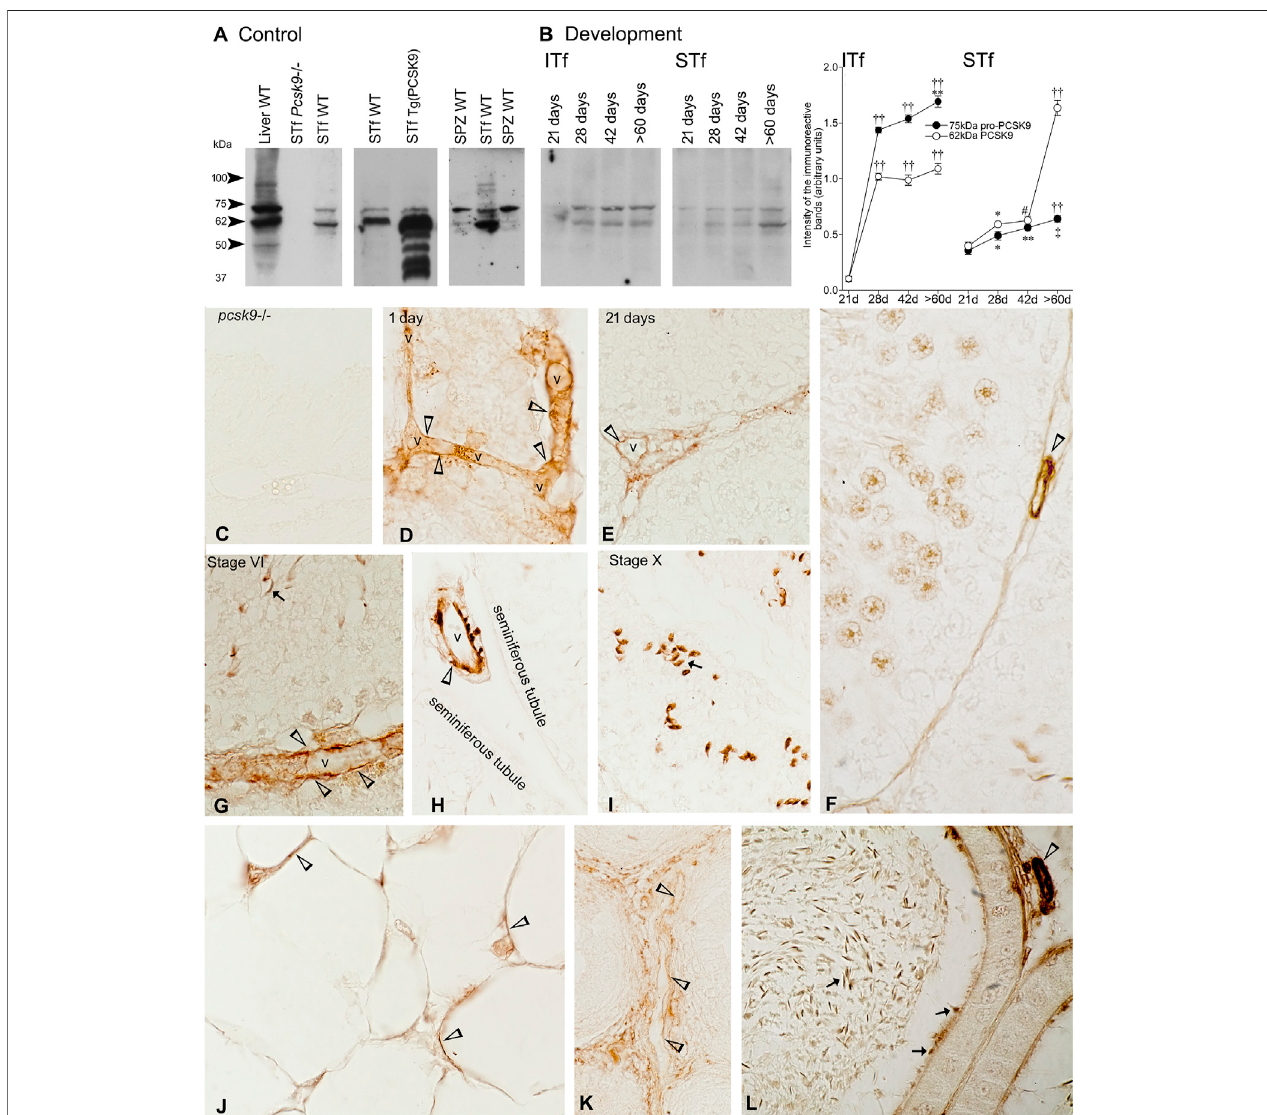
FIGURE 1 | (A) PCSK9 protein expression of in mouse testis and epidydimal spermatozoa. Control : a 75 kDa pro-PCSK9 and 62 kDa PCSK9 immunoreactive bands accompanied by a 50 kDa band and another around 95 kDa are apparent in the WT mouse liver used as positive control. The Pcsk9 − / − mouse seminiferous tubule-enriched fractions(STf) used asnegative controlbandsshow no75 kDapro-PCSK9andno62 kDa PCSK9bands. The75 kDapro-PCSK9and 62 kDa PCSK9 bandsaredetectedintheseminiferoustubule-enrichedfractions(STf)andepidydimalspermatozoa(SPZ); (B) Development:InITf,theincreasesinpro-PCSK9and PCSK9 are signi fi cant: †† p < 0.001 60 days (d) versus (vs.) 21 d and 28 days; 42 d vs. 21 d; 28 d vs. 21 d; ** p < 0.005 60 d vs. 28 d; †† p < 0.001 60 d vs. 21 d; †† p < 0.001 28 d vs. 21 d and †† p < 0.001 42 d vs. 21 d. In STf, the increases in pro-PCSK9 and PCSK9 are signi fi cant: †† p < 0.001 60 days (d) vs. 21 d, ‡ p < 0.03 60 d vs. 28 d;** p < 0.00542 dvs.21 d;* p < 0.0528 dvs.21 d; †† p < 0.00160 dvs.21 d,28 dand42 d; # p < 0.0242 dvs.21 dand* p < 0.0528 dvs.21 d.Thevaluesarethe mean ± SEM; n = 3 per experimental group. (C – K) Immunolocalisation of PCSK9: (C) Pcsk9 − / − mouse testis sections exposed to the PCSK9 antibody showed